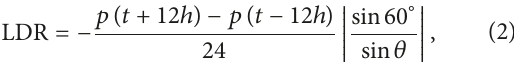
MOD runs and its difference map between the two runs.